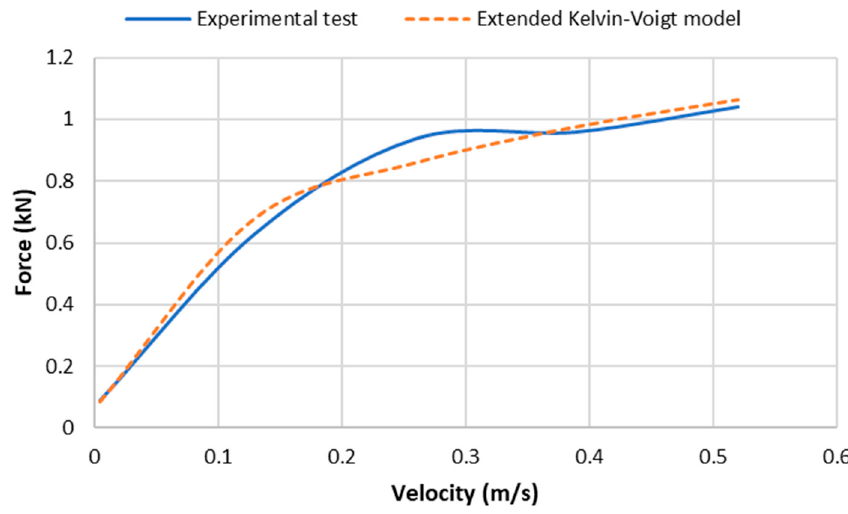
Figure 6. Force vs. velocity: Experimental tests and extended Kelvin–Voigt model.